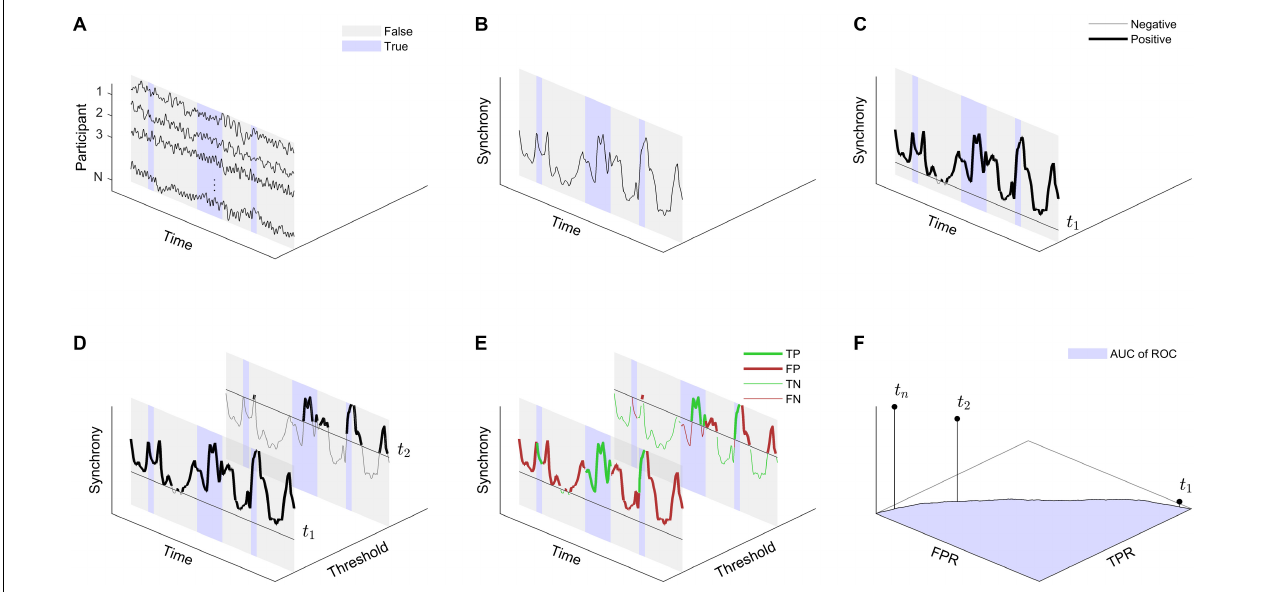
FIGURE 1 | Illustration of the event detection paradigm. (A) Consider the physiological response traces recorded from N participants who were presented with the same external stimuli at the same time. The timestamps of the data recordings can be separated in moments where events were presented and where an event detection would thus be correct (True) and moments where no events where presented and where an event detection would thus be incorrect (False). (B) Rather than considering the raw physiological responses, the detection paradigm is based on the PS between the participants. (C) Now let us define a threshold t . The moments in time where the synchrony is higher than t are marked as an event (Positive) and the moments in time where the synchrony is lower than t are marked as a non-event (Negative). (D) Rather than using a single value for t , we consider a gradually changing threshold t 0 to t n , so that at t 0 all data are marked as Positive and at t n all data are marked as Negative (E) For each iteration t i , we can now define the true positives (TP), false positives (FP), true negatives (TN), and false negatives (FN) and thus compute the true-positive rate (TPR) and false-positive rate (FPR). (F) Plotting the FPR versus the TPR – both as a function of t – results in the receiver operating curve (ROC). Detection performance is defined as the standard metric of area under the ROC (AUC of